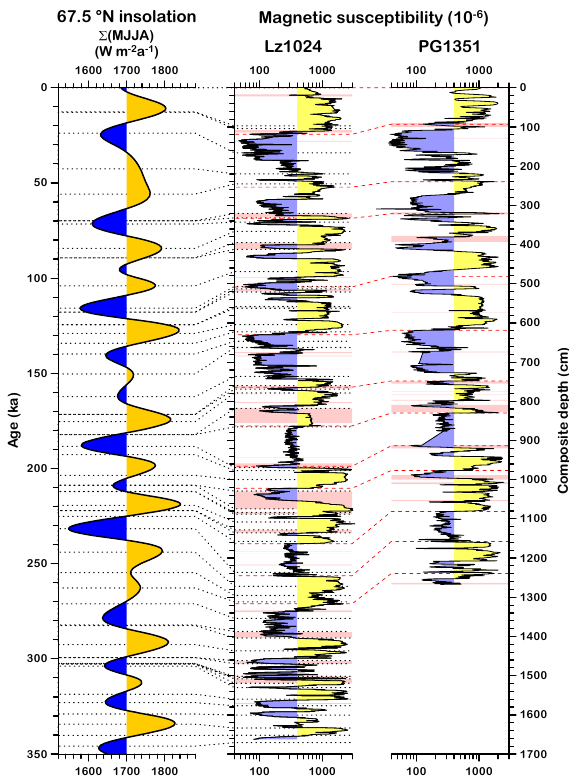
Fig. 2. Correlation of composite cores PG1351 and Lz1024 from Lake El’gygytgyn by means of high-resolution records of magnetic susceptibility, and tuning of these logs to the summer insolation at 67.5 ◦ N according to Laskar et al. (2004) (left). The tuning proce- dure is described in detail in Nowaczyk et al. (2012, 2013). Some prominent correlation levels are marked by dashed red lines. Pink bars denote turbidite